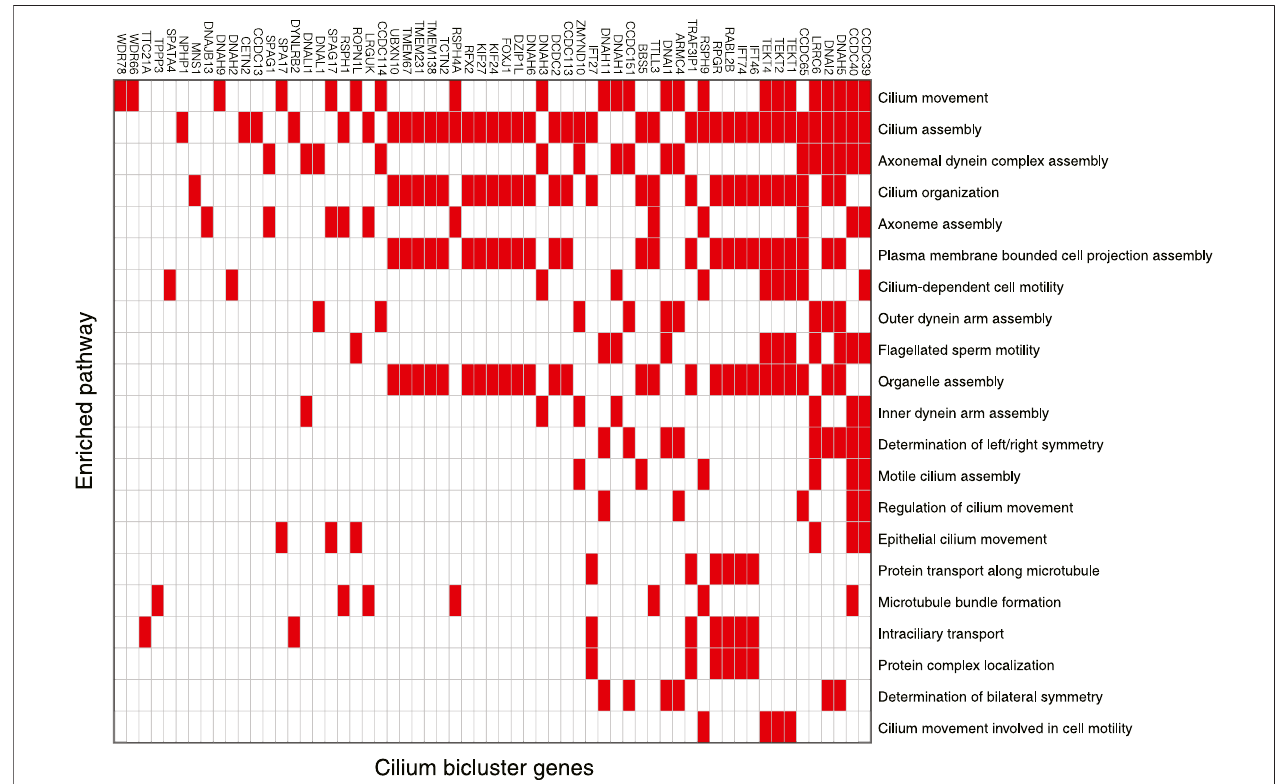
FIGURE 2 | Genes in the cilium bicluster associated with top 20 signi fi cantly enriched GO-BP pathways. Full list of genes and enrichments are available in Supplementary Table S1 .